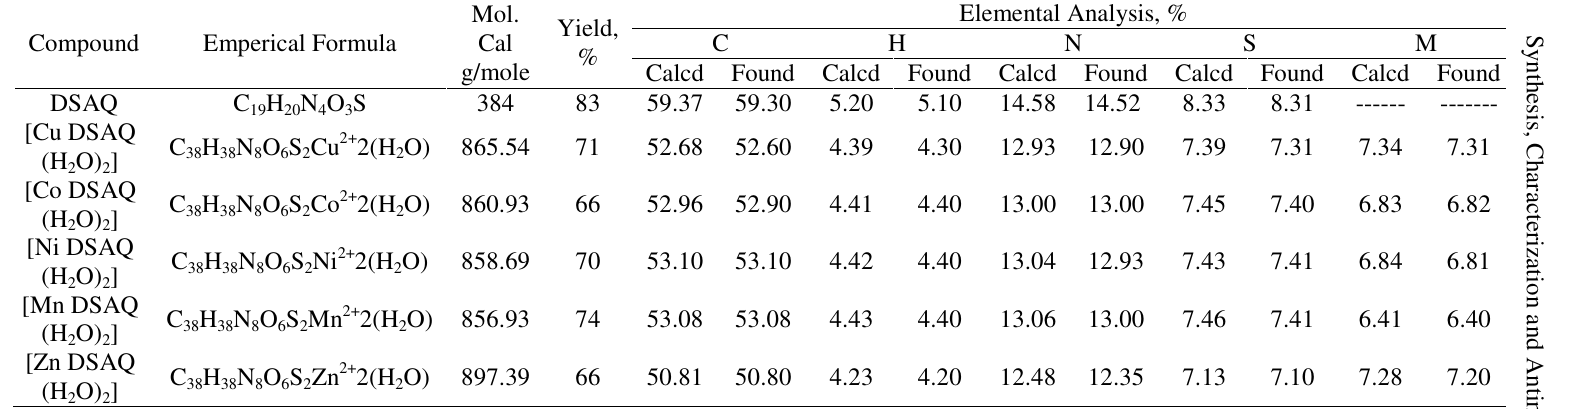
Table 1. Analytical data of DSAQ ligand and its metal